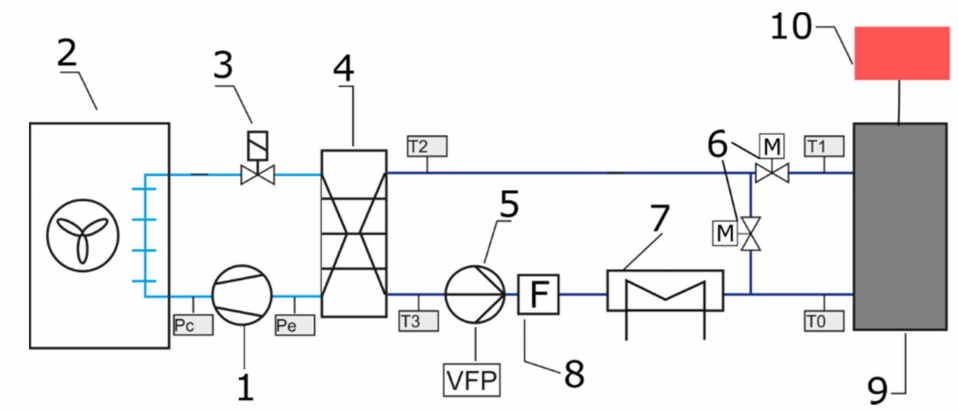
Figure 6. Layout of experimental setup: 1—compressor, 2—condenser, 3—electronic expansion valve, 4—evaporator, 5—circulating pump, 6—control valves, 7—electric heater, 8—flowmeters, 9—calorimeter, 10—electric heater power